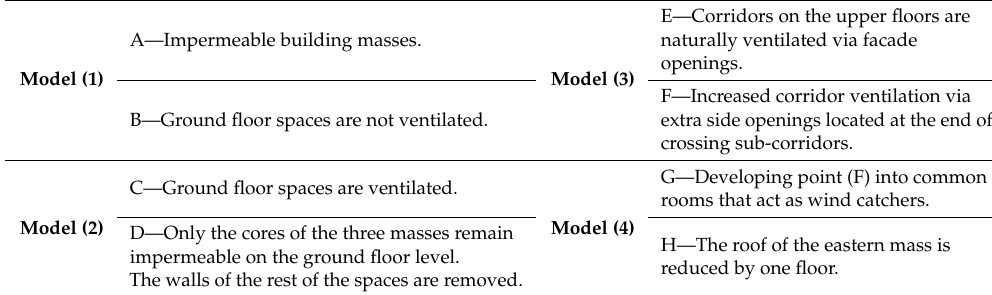
Table 1. Key characteristics of the simulated computational fluid dynamics (CFD)